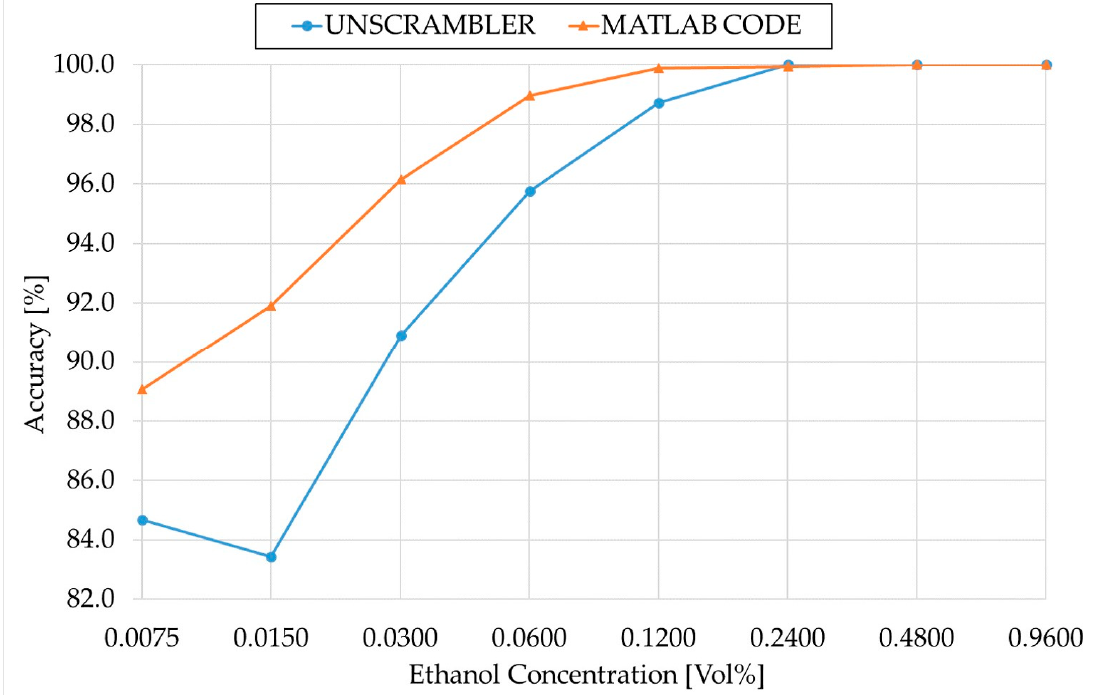
Figure 5. Comparison of the accuracy from The Unscrambler X and the MATLAB code.